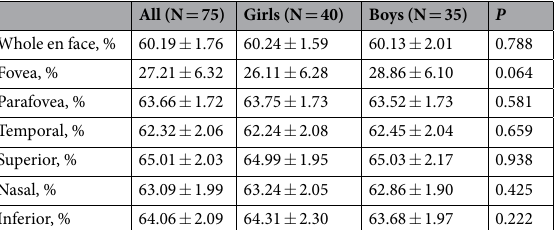
Table 3. Mean vascular flow density in the deep capillary plexus measured by OCT angiography according to sex.